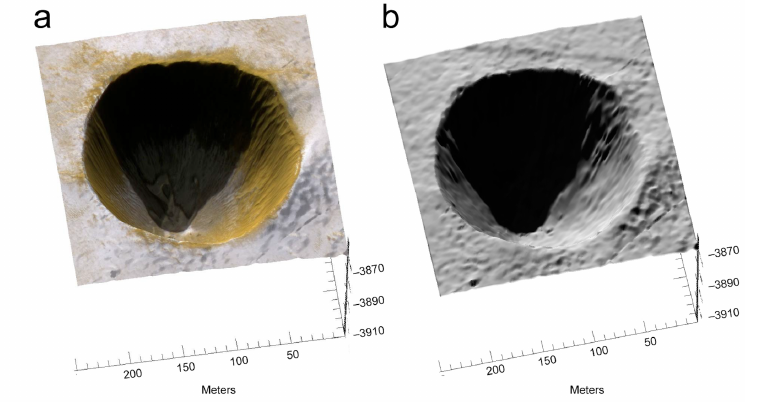
Figure 10. Perspective view of a detail of the orthoimage ( a ) draped over a 3D rendering of the DTM (DTEPC_009689_2645_010084_2645_A01). The shadows in the shaded relief map ( b ), created with simulated illumination angles matching those of the source image closely resemble the shadows in the image, providing a qualitative measure of the DTM resolution. X and Y values are distance (m). Z values are elevation